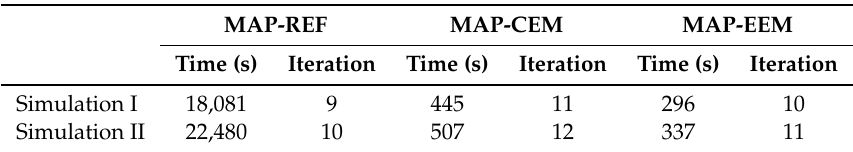
Figure 2. Standard deviations of the posterior distribution approximation of the simulations with smooth inclusions. Standard deviations of MAP-REF reconstructions ( first column ), MAP-CEM reconstructions ( second column ) and MAP-EEM reconstructions ( third column ). The first row presents the results for the absorption coefficients and the second row for the scattering coefficients. The units of axes are in mm and colorbars in mm − 1 . Table 4. Computation times in seconds and iterations done before the solution was converged for the Gauss–Newton algorithm for MAP-REF, MAP-CEM and MAP-EEM reconstructions for Simulation I (first row) and Simulation II (second